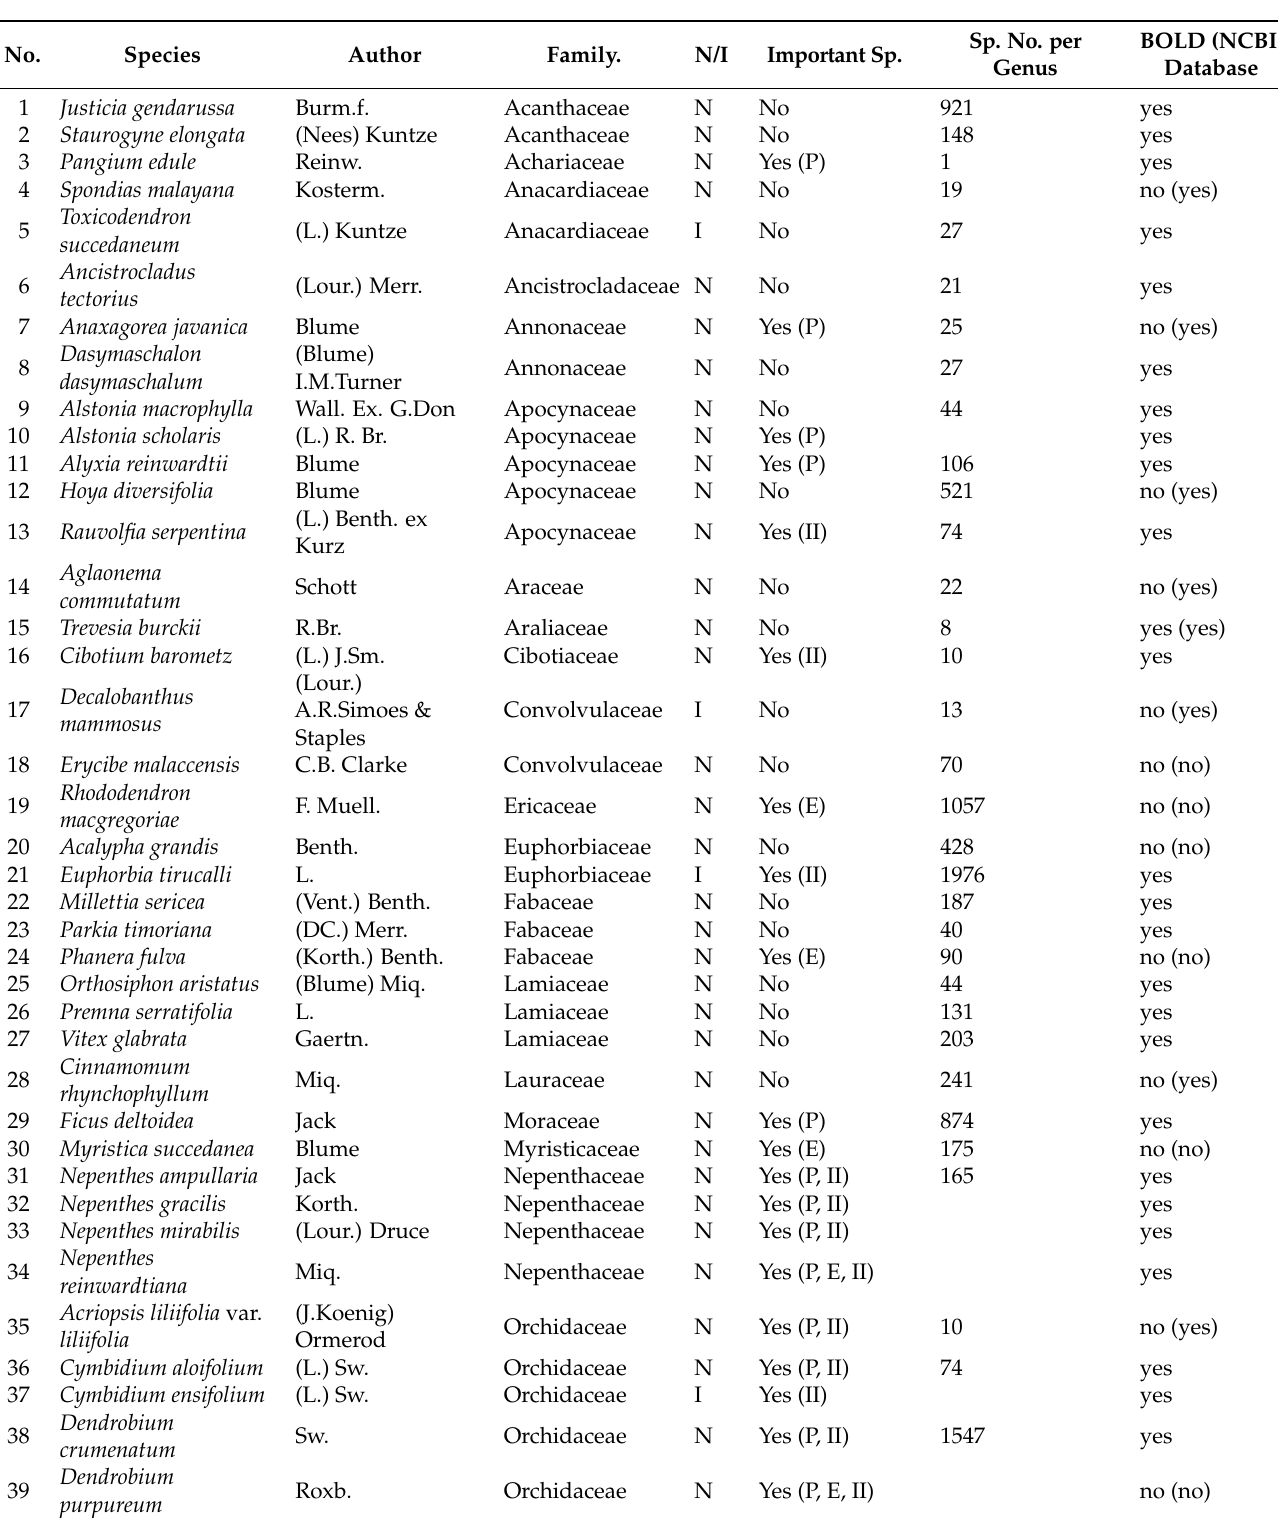
Table 1. The Indonesian medicinal plants (n = 61) used in this study with related information from literature